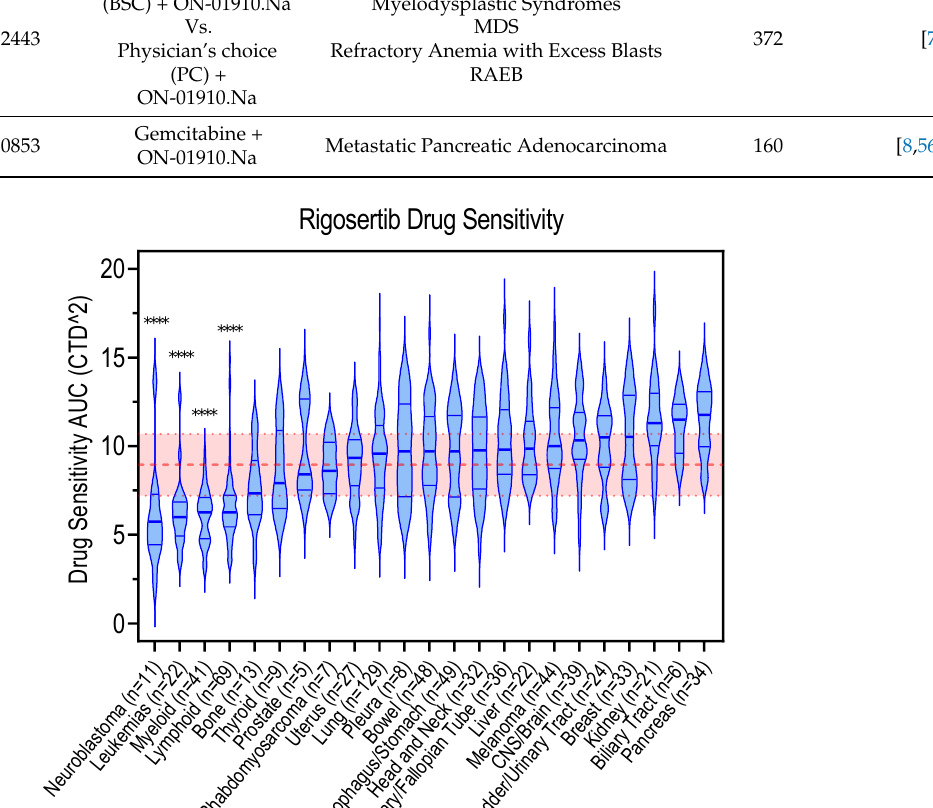
Figure 3. Data adapted from the DepMap Portal, retrieved from the Cancer Therapeutics Response Portal (CTRP), showing the sensitivity of cancer-cell lines of multiple origins to rigosertib. AUC reflects the area under the concentration-response curve. The lower the AUC, the more sensitive the cell line. Violin plots show median rigosertib sensitivity values (thick blue line). The thick dashed red line shows the average of all median AUCs. The shaded red area is defined by the standard deviation of the average median values. An unpaired t-test was performed, comparing the neuroblastoma, leukemias, myeloid, or lymphoid cohorts with the rest of all cohorts together and significance is indicated by p < 0.0001 (****). The number of cell lines (n) in each cohort is indicated in the X axis. Statistics were calculated using GraphPad Software version 9.5.1. Table 1. Summary of rigosertib clinical trials.